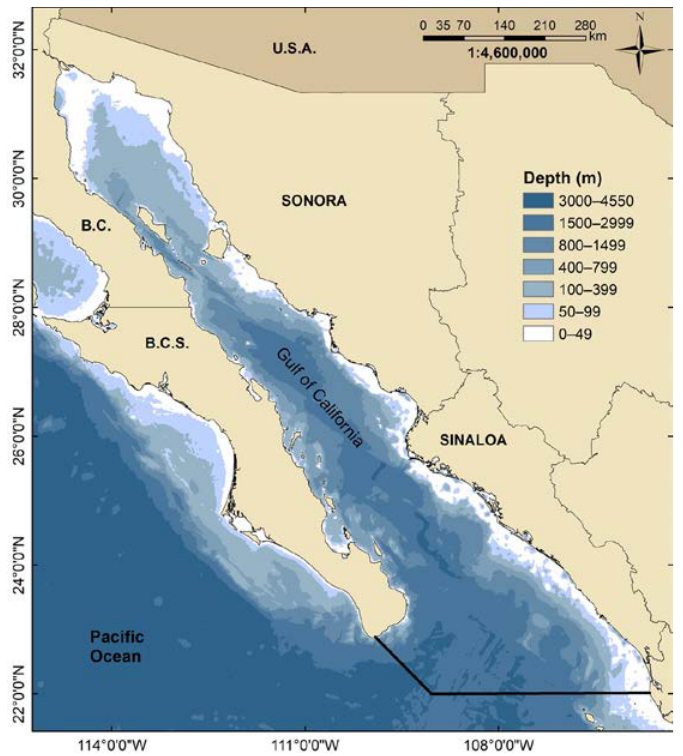
Figure 1. Gulf of California, México, for the oceanic mesoscale events (1998–2019) analyses.